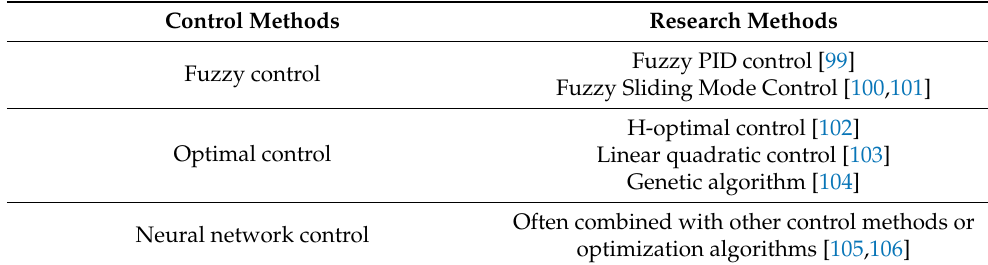
Table 3. Control methods for vehicle vibration damping